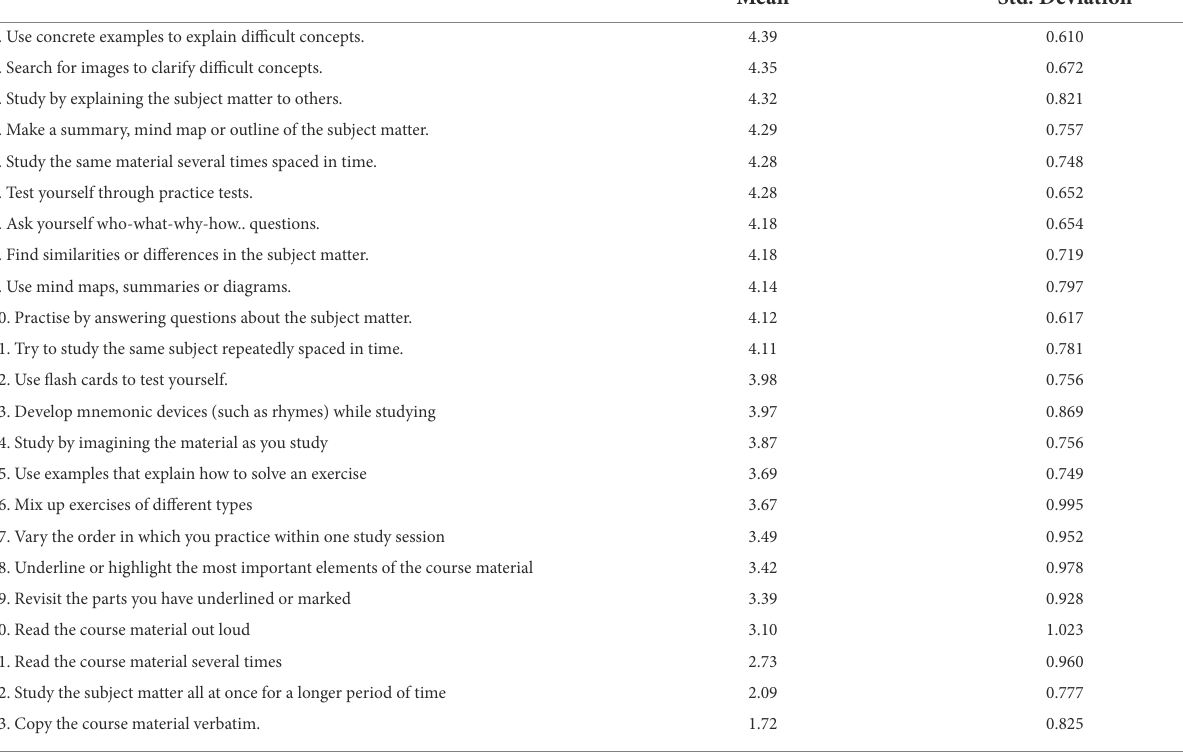
TABLE 6 Perceived effectiveness of learning strategies as reported by novice